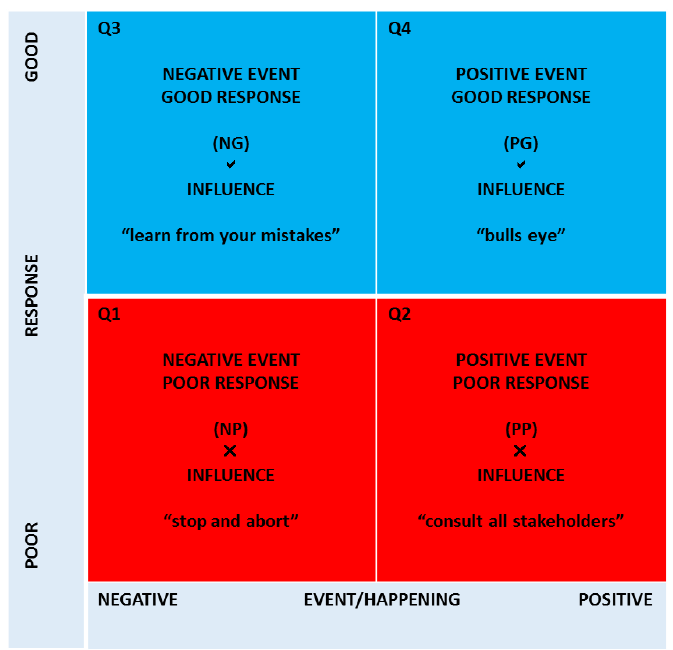
Figure 2. Qualitative Research Adjudication Matrix